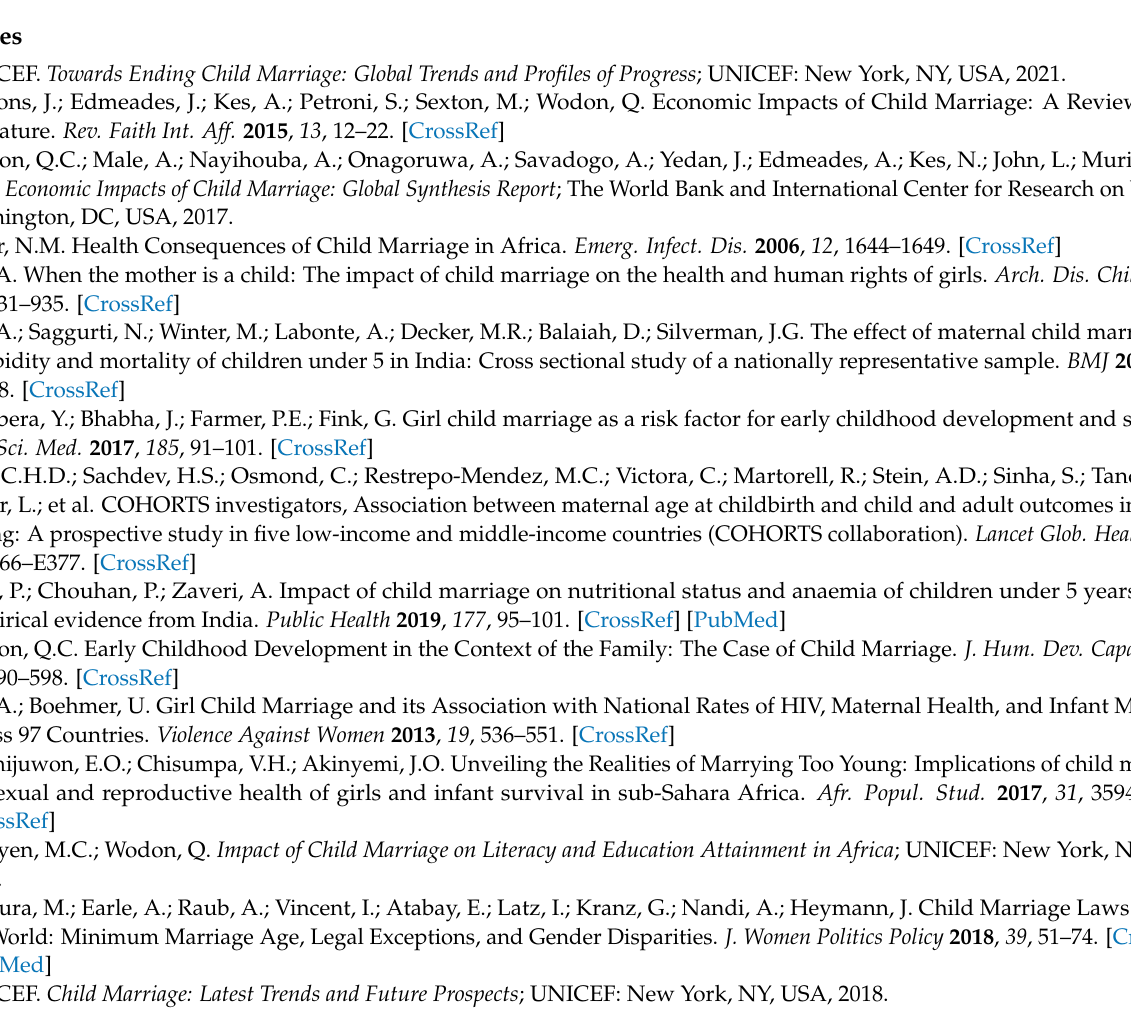
Table S1: Prevalence of Disability Stratified by Participant Age, Household Wealth, Highest Level of Education and Country Economic Classification Group; Table S2: Prevalence of Child Marriage Stratified by Participant Age, Household Wealth, Highest Level of Education and Country Economic Classification